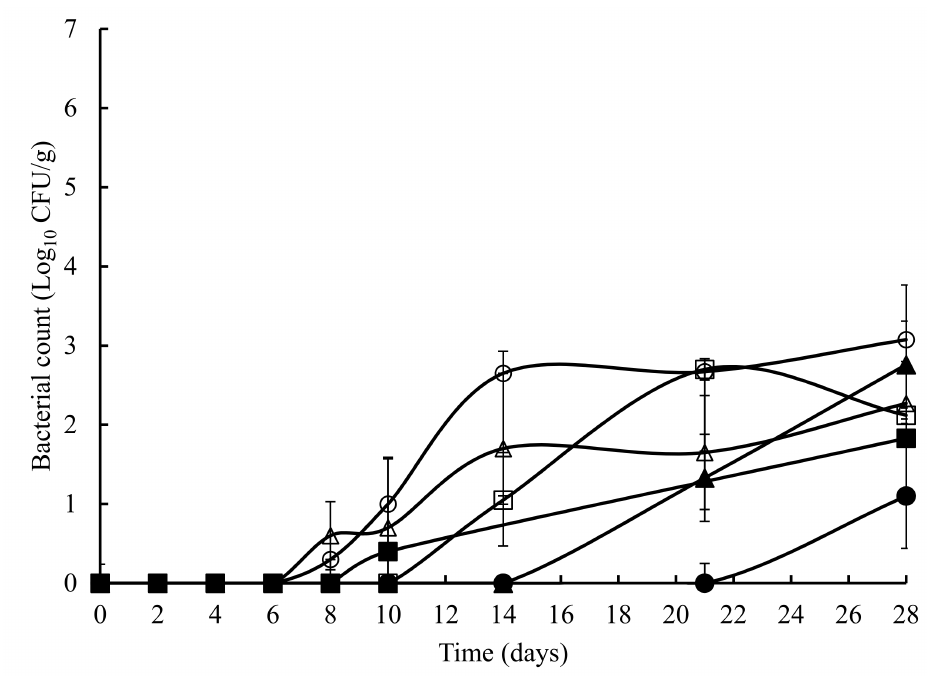
Figure 2. The total Enterobacteriaceae count in crab meat samples stored at 4 ◦ C with the following treatments: SDW ( (cid:4) ), Ascorbic Acid ( ), Casein ( (cid:78) ), Casein & Ascorbic Acid ( (cid:3) ), Potato Starch (o), and Potato Starch & Ascorbic Acid ( ∆ ). The error bars represent 1 standard